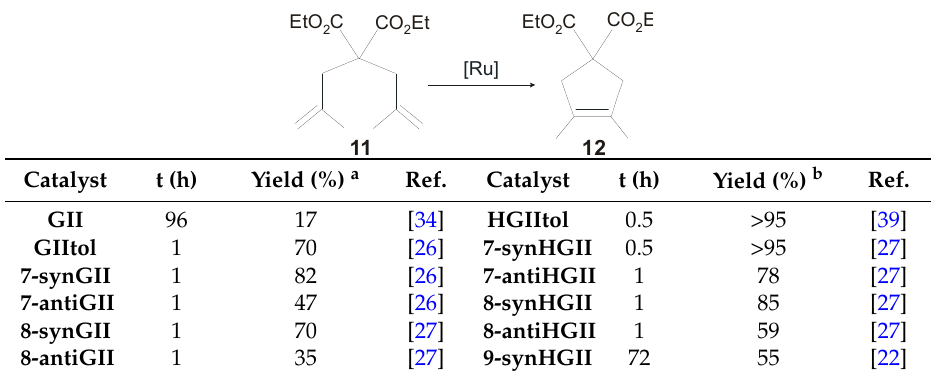
Table 3. RCM of dietyl dimethallylmalonate 11 .